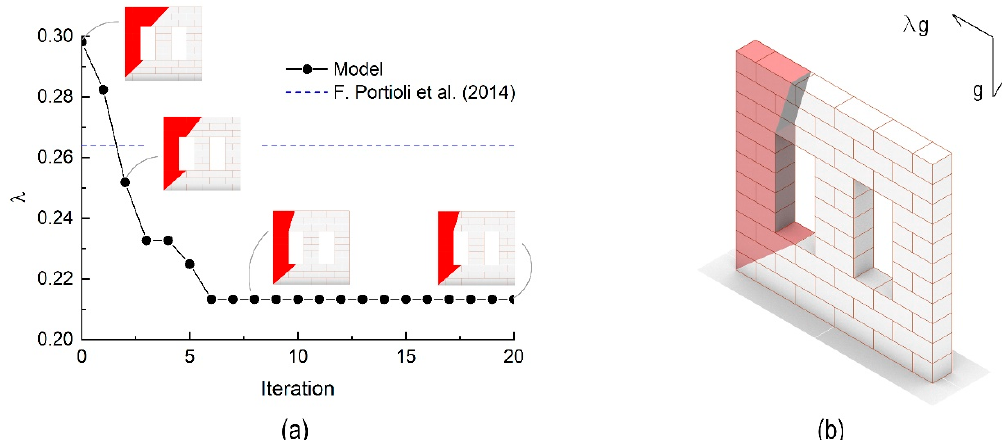
Figure 7. ( a ) Load multiplier vs. Iterations and comparison with the reference value arising from a micro-block model [39]. ( b ) Geometry representation of the failure mechanism at the last iteration.